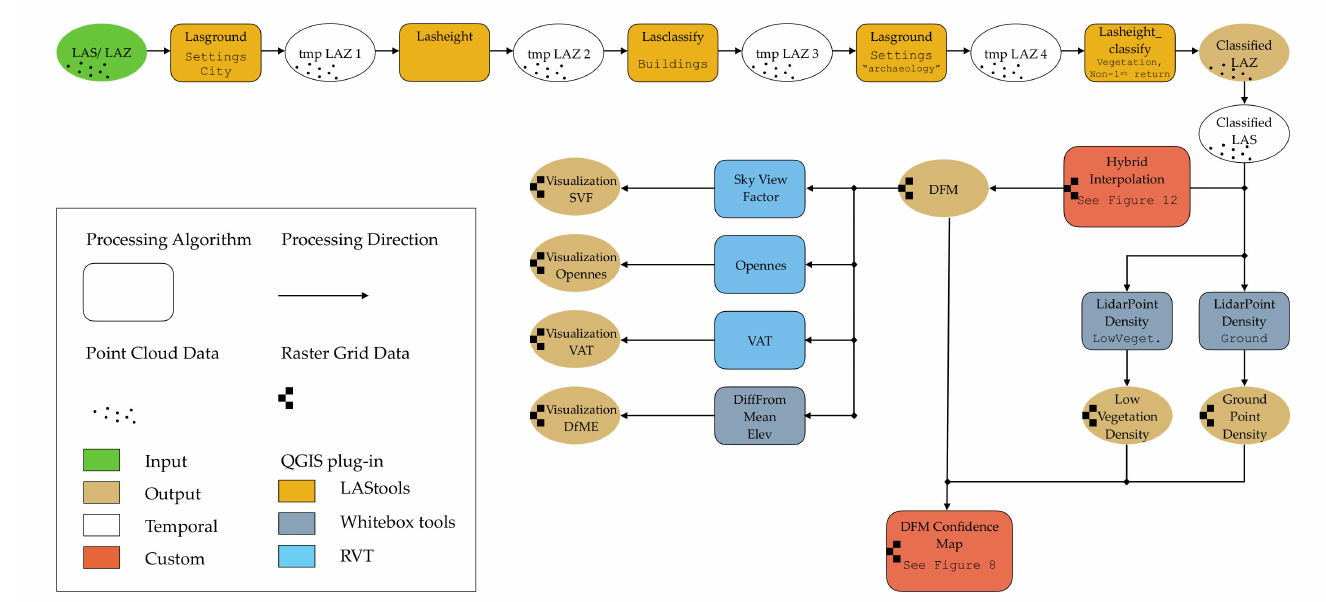
Figure 13. Pipeline